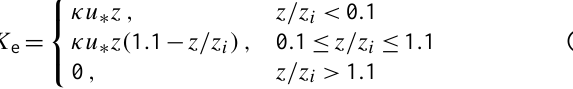
Reaction n Rate Reference